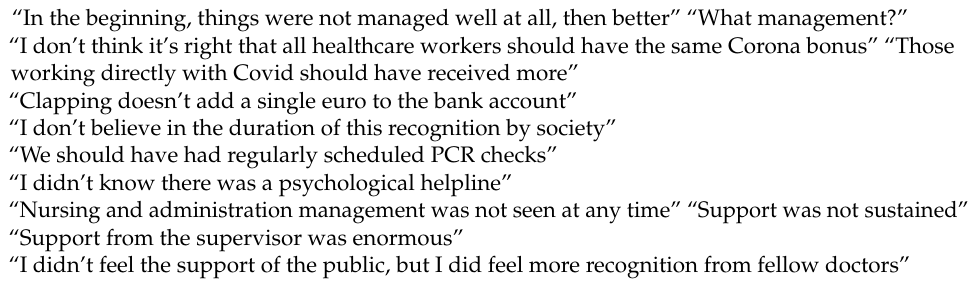
Table 4. Selected comments from the Satisfaction